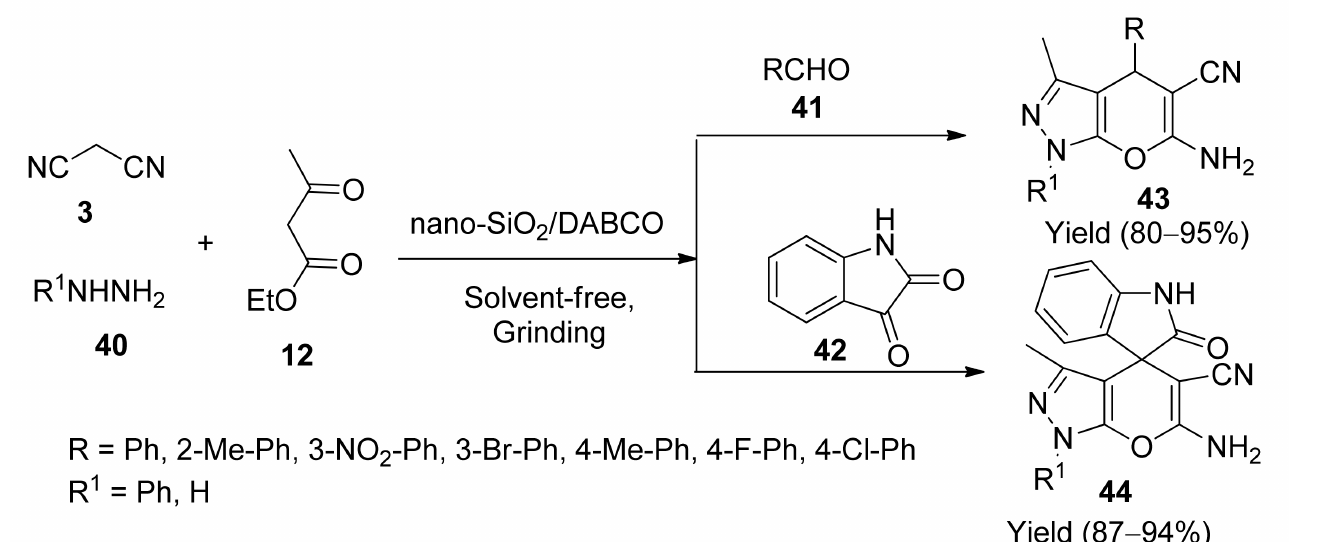
Scheme 11. Synthesis of pyranopyrazole 43 and spiro-pyranopyrazole 44 using SiO 2